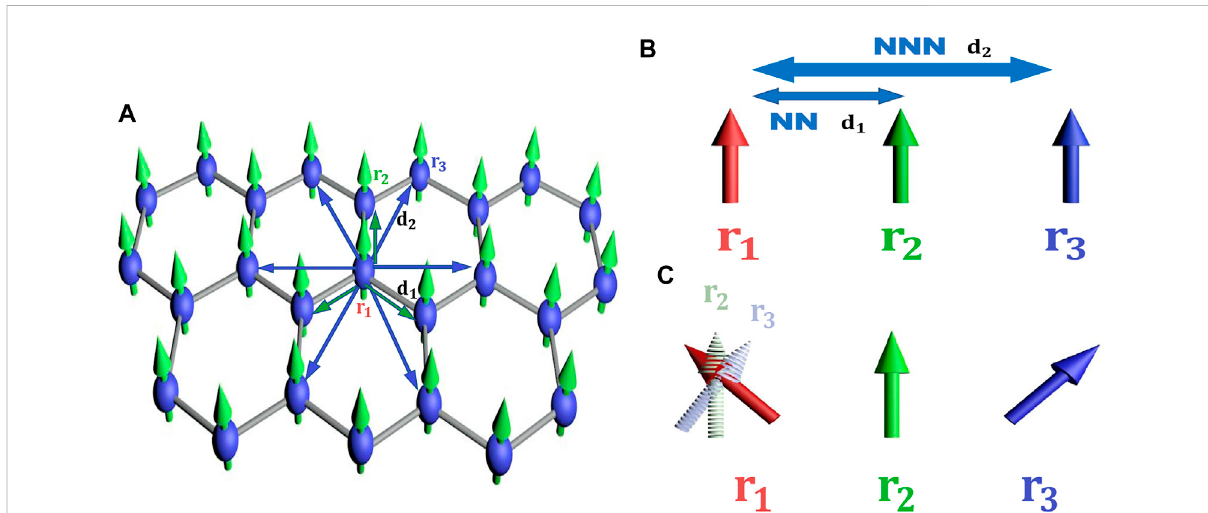
FIGURE 1 Schematicviewoftheroleofnext-nearest-neighborexchangeinteractionsonthespintextures. (A) Single-layeredferromagneticmaterialwith a hexagonal lattice, where r 1 , r 2 , and r 3 denote the original point, the fi rst nearest-neighbor position, and the next nearest-neighbor position, respectively. (B) Both the fi rst-nearest-neighbor and next-nearest-neighbor exchange interactions prefer the parallel spins in a ferromagnetic state. (C) First-nearest-neighbor and next-nearest-neighbor exchange interactions prefer the tilted spins for different directions in a nonferromagnetic